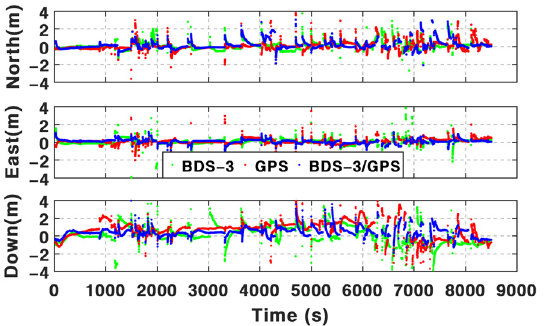
Figure 8. Positioning differences between BSSD PPP and BSSD PPP/INS TCI with different GNSS.